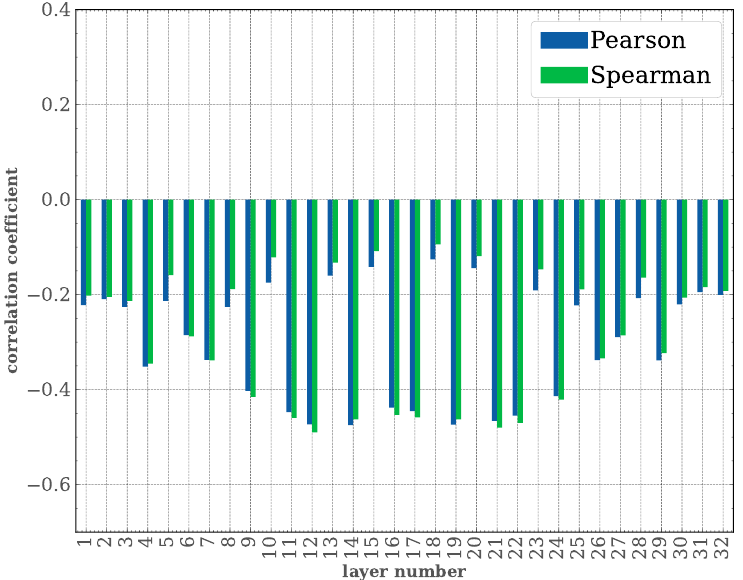
Figure 15. Correlation coefficients for tensile KDF related to waviness